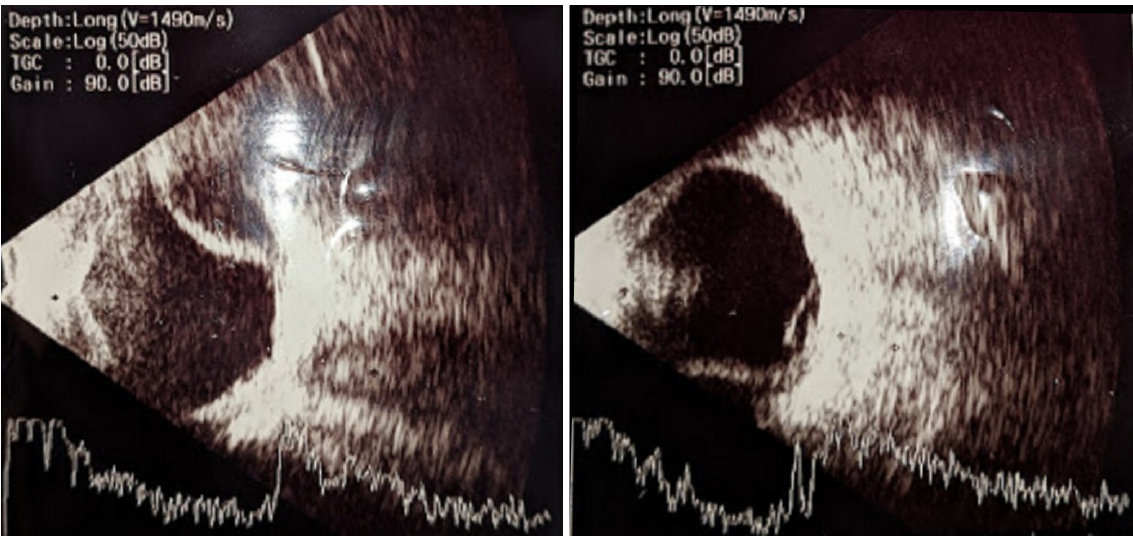
Figure 2: B-scan ultrasonography showing choroidal detachment and exudative retinal detachment on the 1 st postoperative day